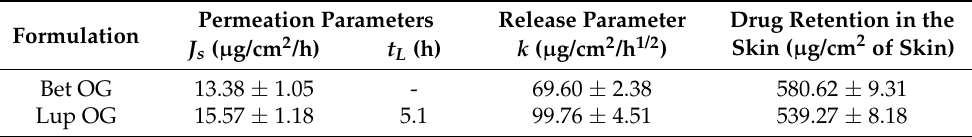
Table 4. The permeation and release parameters of active compounds from oleogel formulations through pig ear skin a and the amounts of active compounds accumulated in the skin samples.